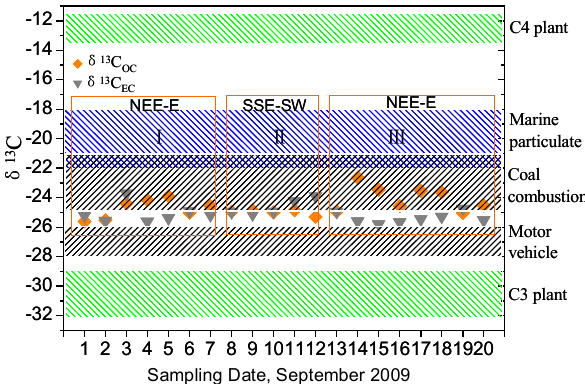
Fig. 5. The variations of stable carbon isotope for OC and EC at Pudong ( δ 13 C of major emission sources including coal- combustion (Gleason and Kyser, 1984; Widory, 2006), biomass burning from C3 and C4 plants (Martinelli et al., 2002; Moura et al., 2008), and motor vehicle exhaust (Widory,